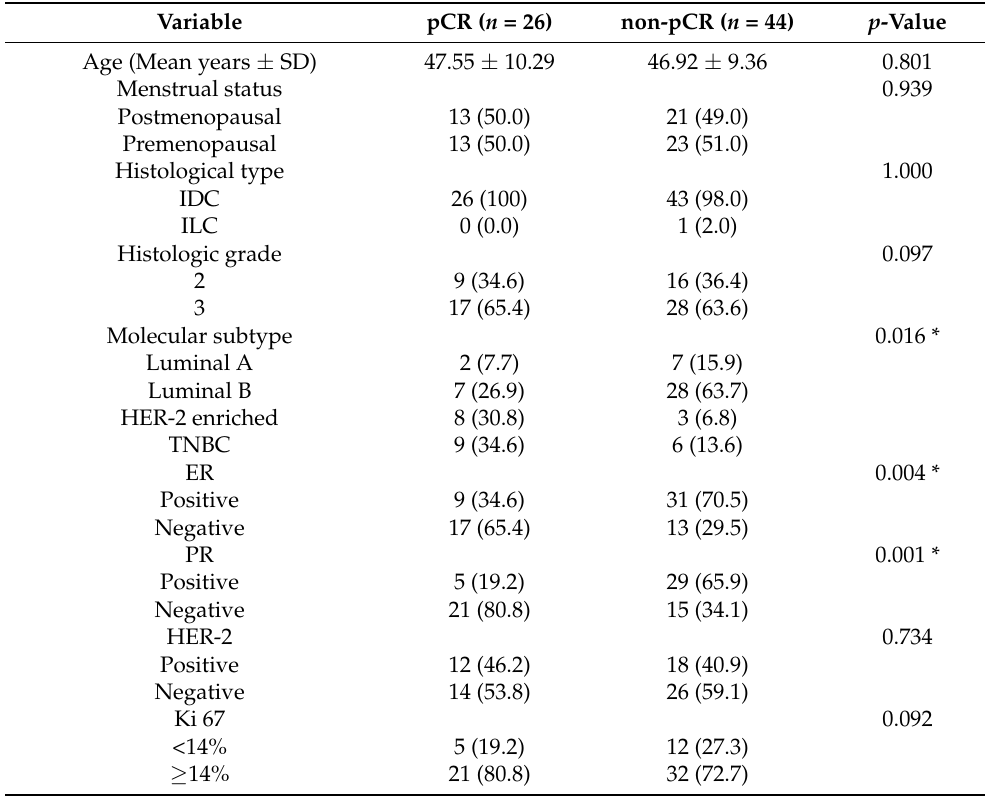
Table 1. Patient Characteristics.